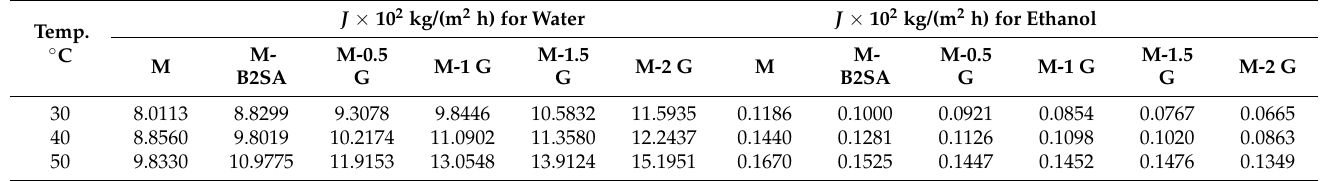
Table 5. Permeation flux of water and permeation flux of ethanol for all the membranes for different temperatures. Temp. °C M